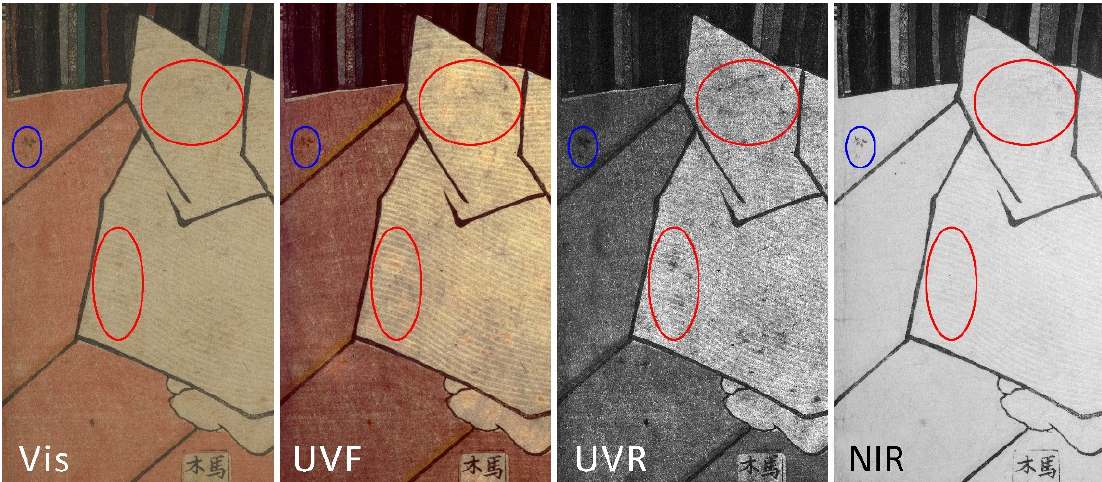
Figure 2. Detail of print 3a showing that, through a multiband acquisition using Vis, UVF, UVR and NIR, it is possible to provide a complete mapping of decay, such as stains (blue circles) and discolorations (red circles).